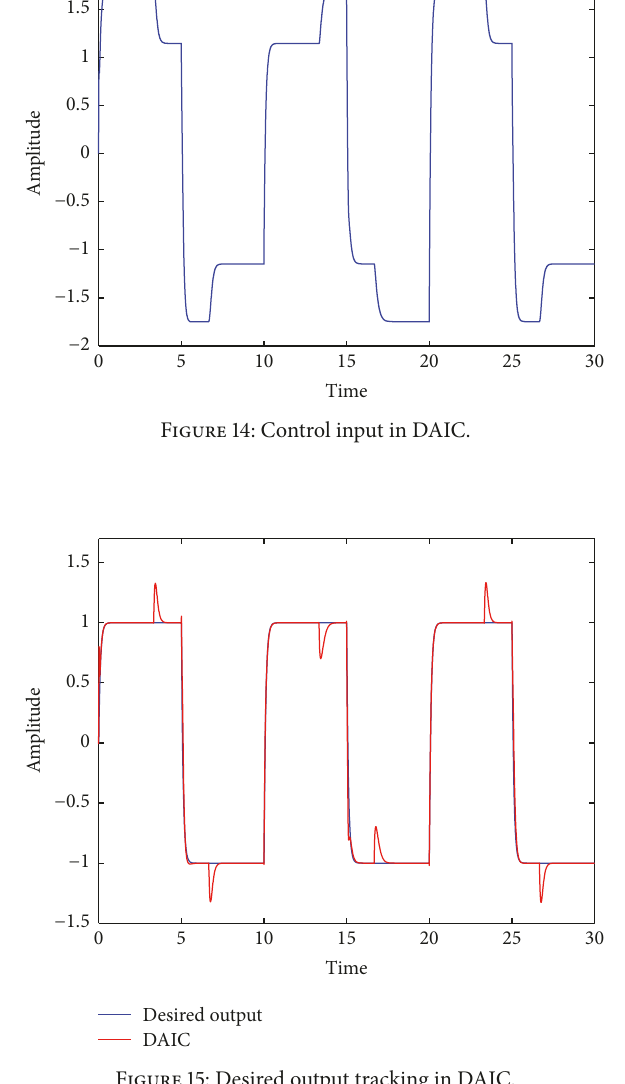
Figure 15: Desired output tracking in DAIC.